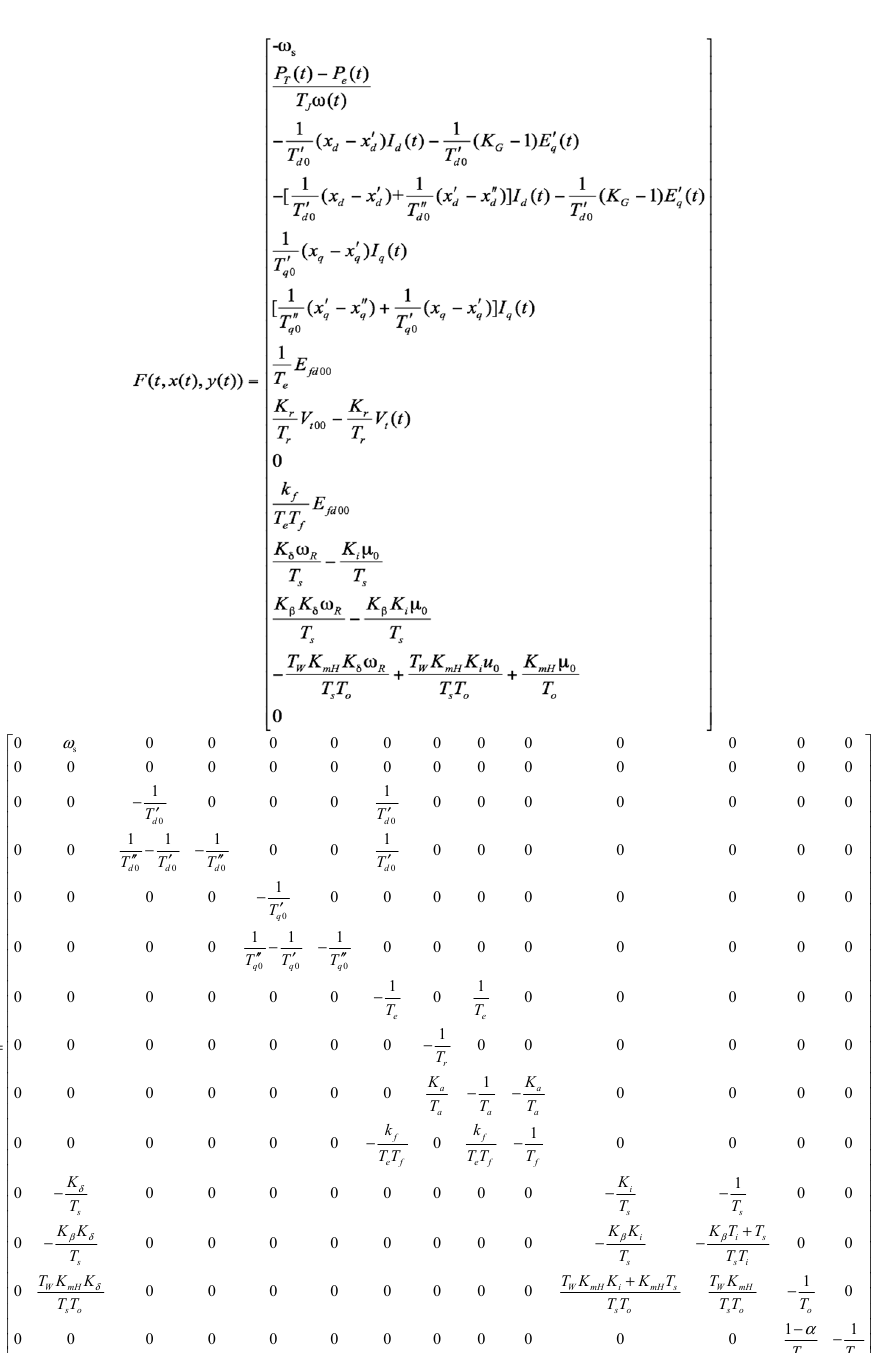
Figure 3. The constant matrix H and virtual input F ( t , x ( t ) , y ( t ))